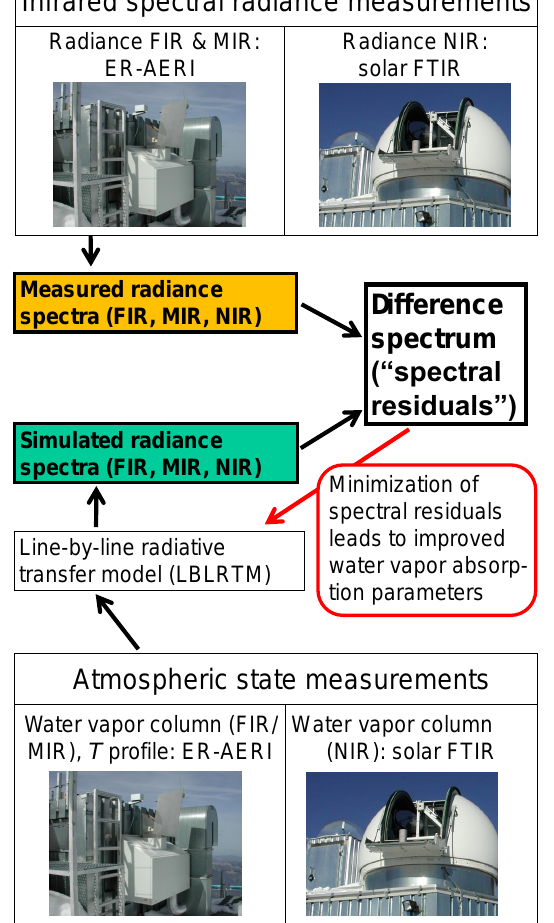
Figure 2. Logical scheme of the Zugspitze radiative closure exper- iment. Simulated radiance spectra are based on atmospheric-state measurements performed coincidently with the radiance measure- ments. The closure idea is to minimize spectral residuals between simulated and measured radiance spectra by iteratively adjusting and improving the water vapor absorption parameters used in the FIR, MIR, and NIR spectral radiance simulations.